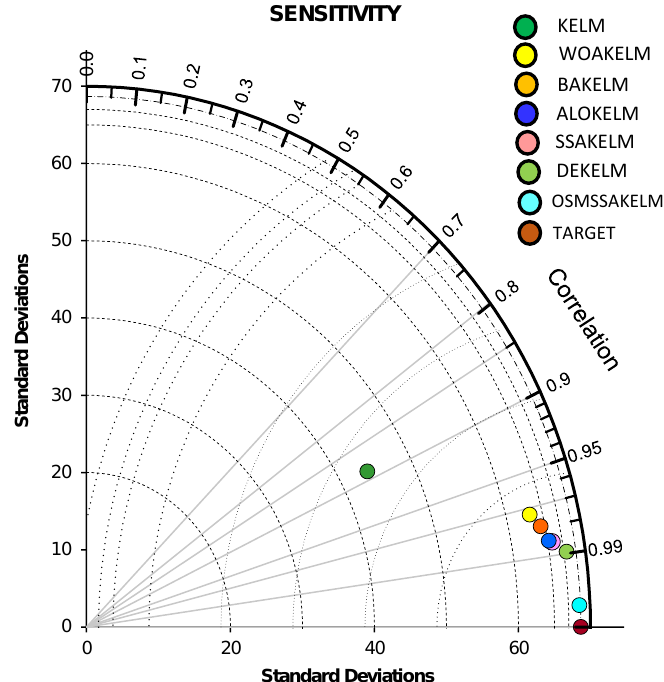
Figure 15. Taylor plot of optimized KELM models for the training phase.